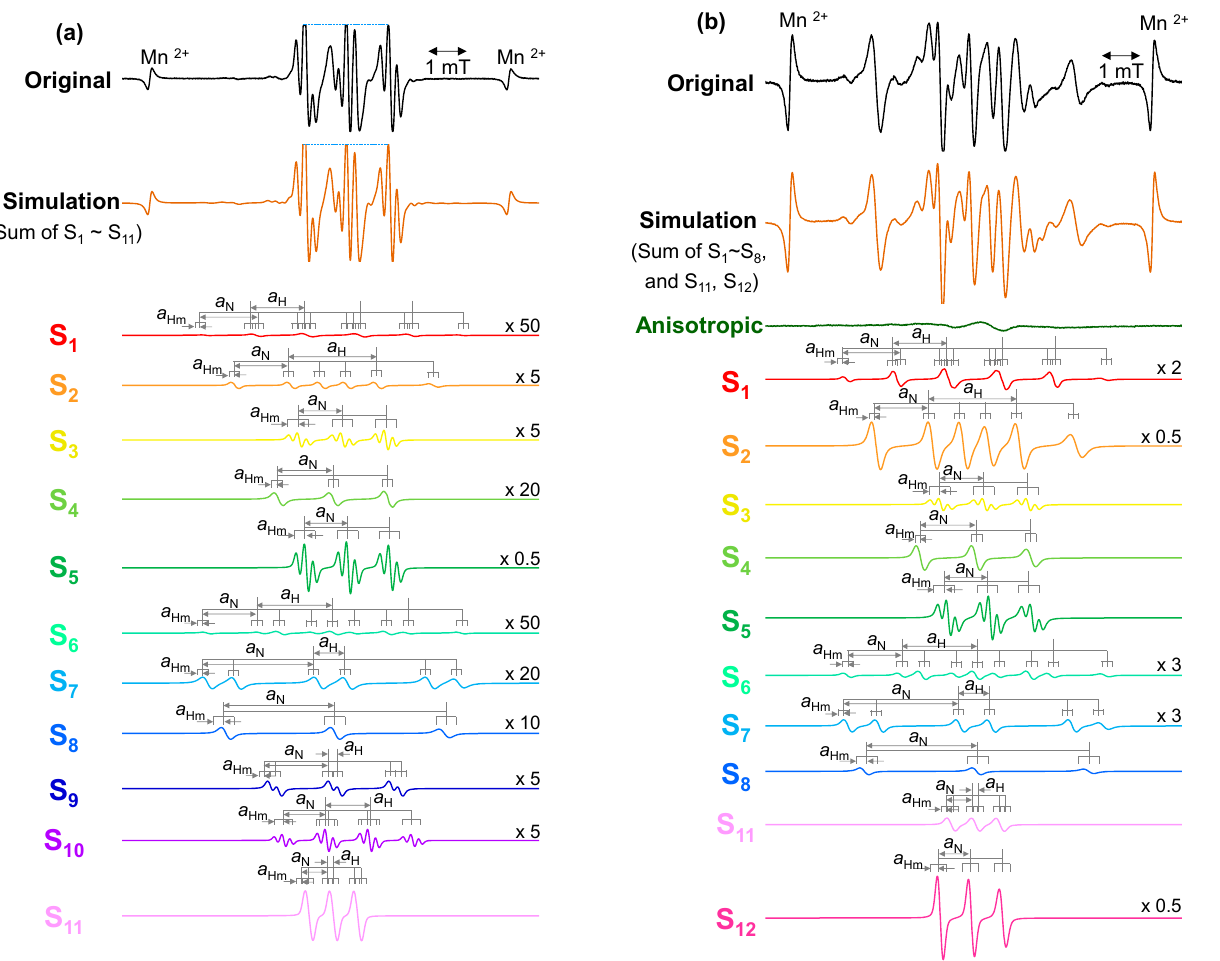
Figure 6. ESR spectra and simulated spectra of ( a ) pristine homopolymer PP-H observed at 180 °C, and ( b ) oxidized random copolymer OPP-R observed at 130 °C. The parameters a H , a N , and a Hm are the hyperfine coupling constants ( hfcc) .